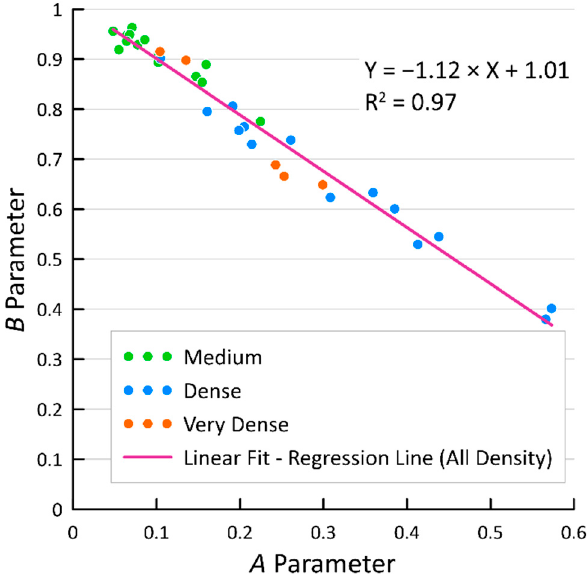
Figure 10. Correlation of A and B parameter for double-normalization.